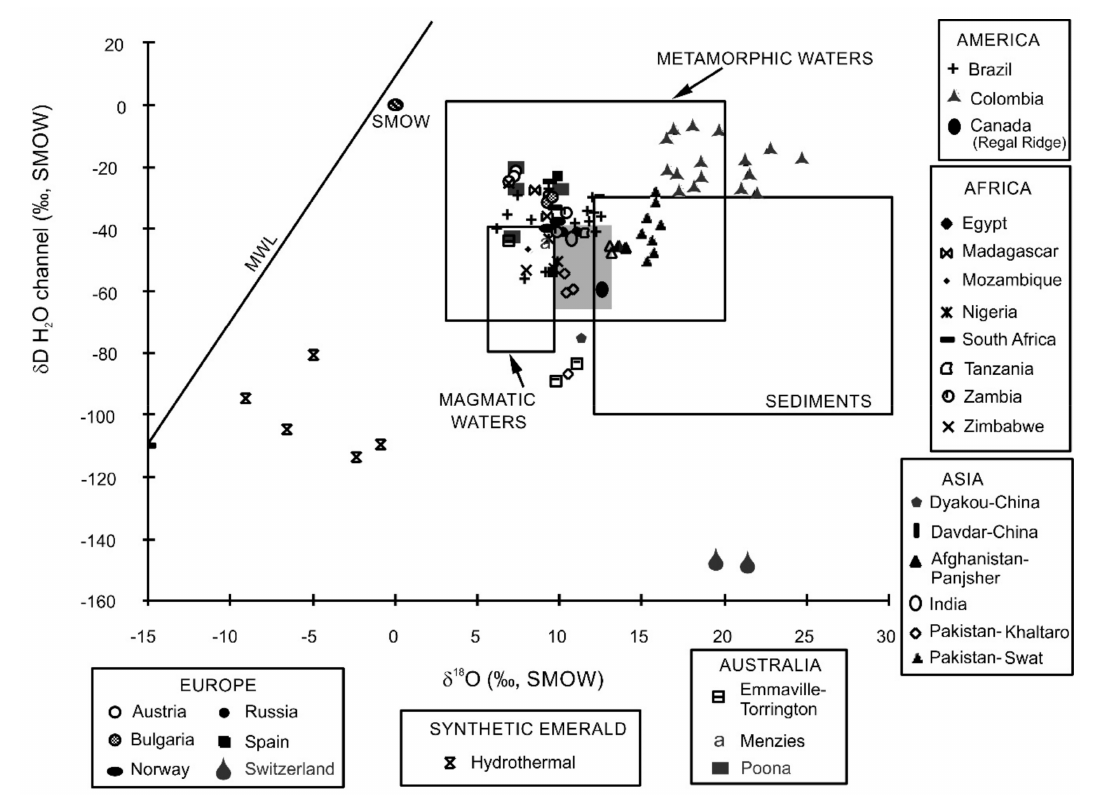
Figure 33. Channel δ D H 2 O versus δ 18 O for emerald worldwide [15,76,157,158]. The isotopic compositional fields are from [159], including the extended (Cornubian) magmatic water box (grey). MWL = Meteoric Water Line, SMOW = standard mean ocean